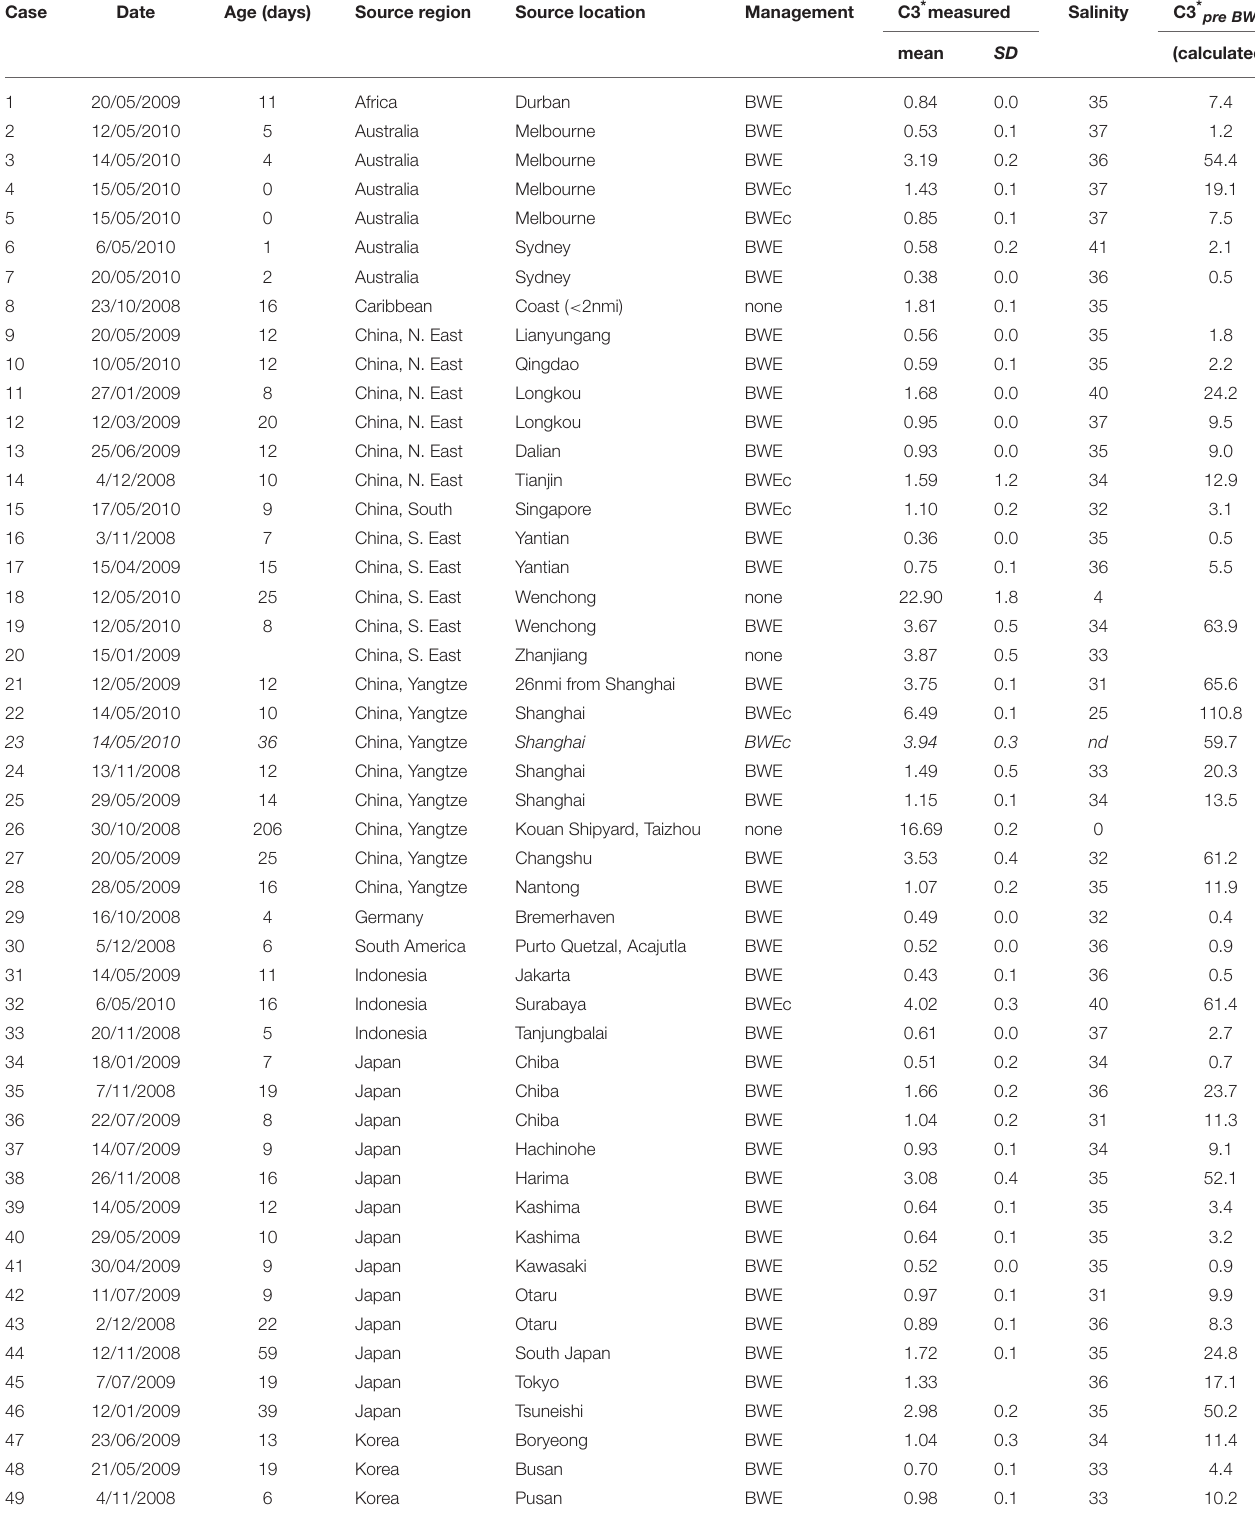
TABLE 1 | Mean fluorescence intensities (C3 * = 370/494nm) measured in randomly sampled ballast tanks in ships arriving to Pacific Ocean ports in this study.